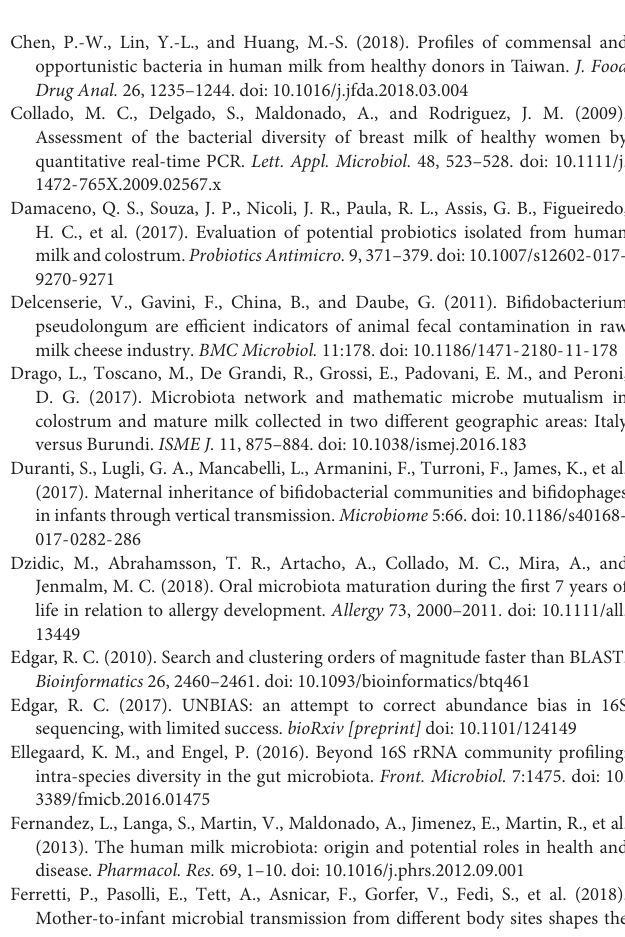
comparison of microbiota in feces and breast milk samples. The genera listed in green describe breast milk, genera listed in blue describe infant feces, and genera listed in red describe maternal feces samples. Significant bacterial genera were determined by Kruskal–Wallis test ( P < 0.05) with LDA score greater than 3. (B) Cladogram representation of differentially abundant bacterial taxonomic group detected using LEfSe. Different colors indicate the group in which clade was most abundant. Supplementary Figure 2 | Phylogenetic tree constructed based on the bifidobacterial ASV sequences. Outer circle color represents the phylogenetic